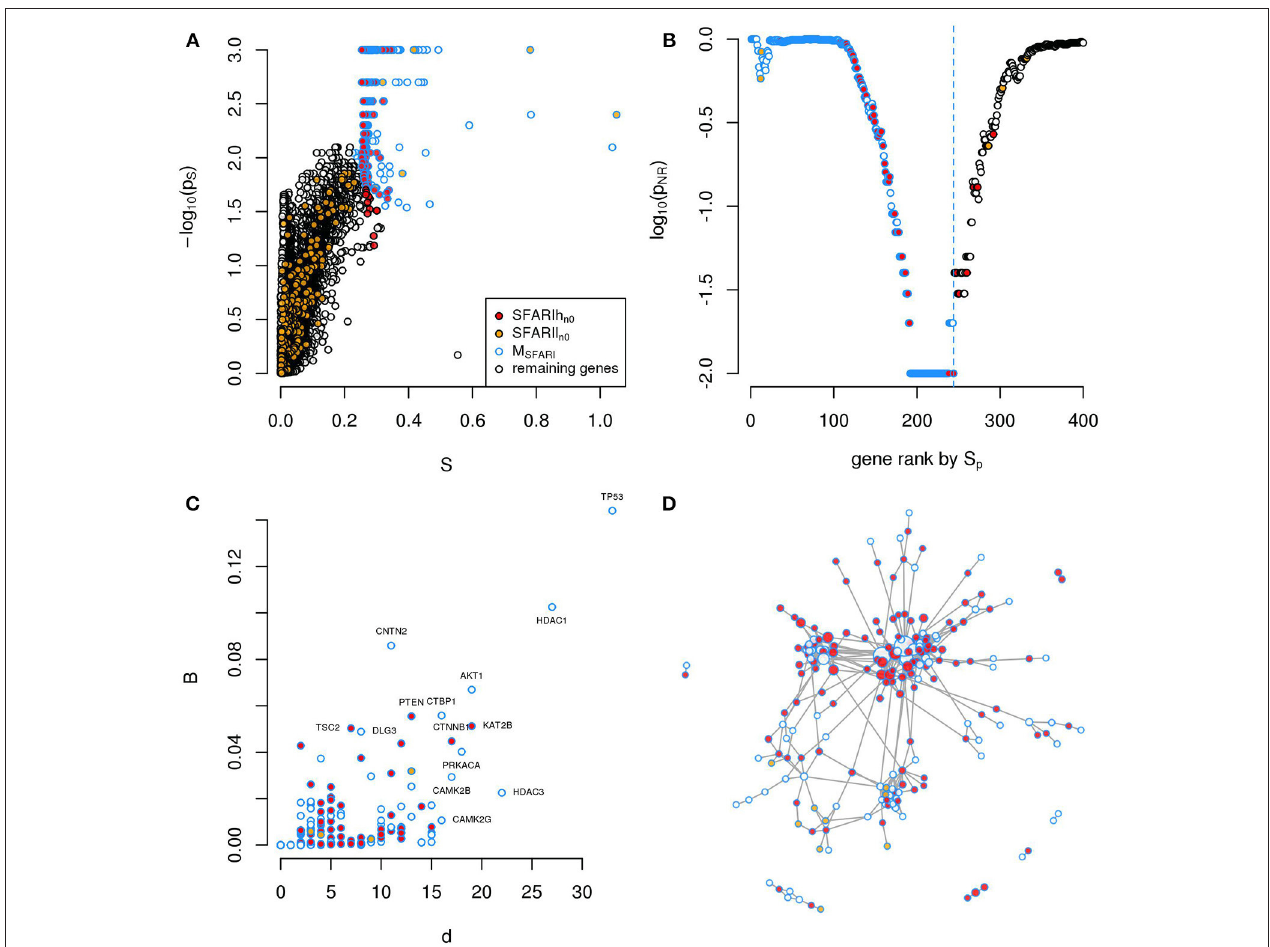
FIGURE 1 | A significantly connected gene module based on SFARIh genes. The network-diffusion based analysis of SFARIh genes (red) leads to the definition of a significantly connected gene module of 244 genes (blue border). (A) Network smoothing index and corresponding estimated p -value ( p s ). (B) For each rank n (horizontal axis), the estimated p -value ( p NR ) that quantifies the significance of the gene network defined by the genes ranked up to the n -th rank. (C) Number of interactions ( d ) and normalized betweenness ( B ) of genes in M SFARI . (D) Visualization of M SFARI gene module, in which genes are circles and PPI are links; circle size is proportional to gene degree. (A–D) G : all genes included in the STRING